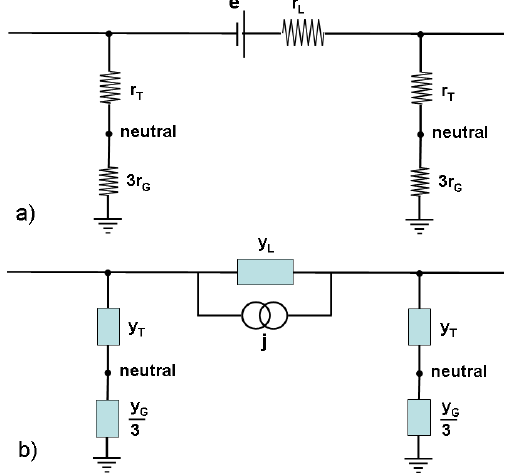
Figure 2. Representation of geomagnetic induction in a power sys- tem using: (a) impedance network and voltage sources, and (b) ad- mittance network and current